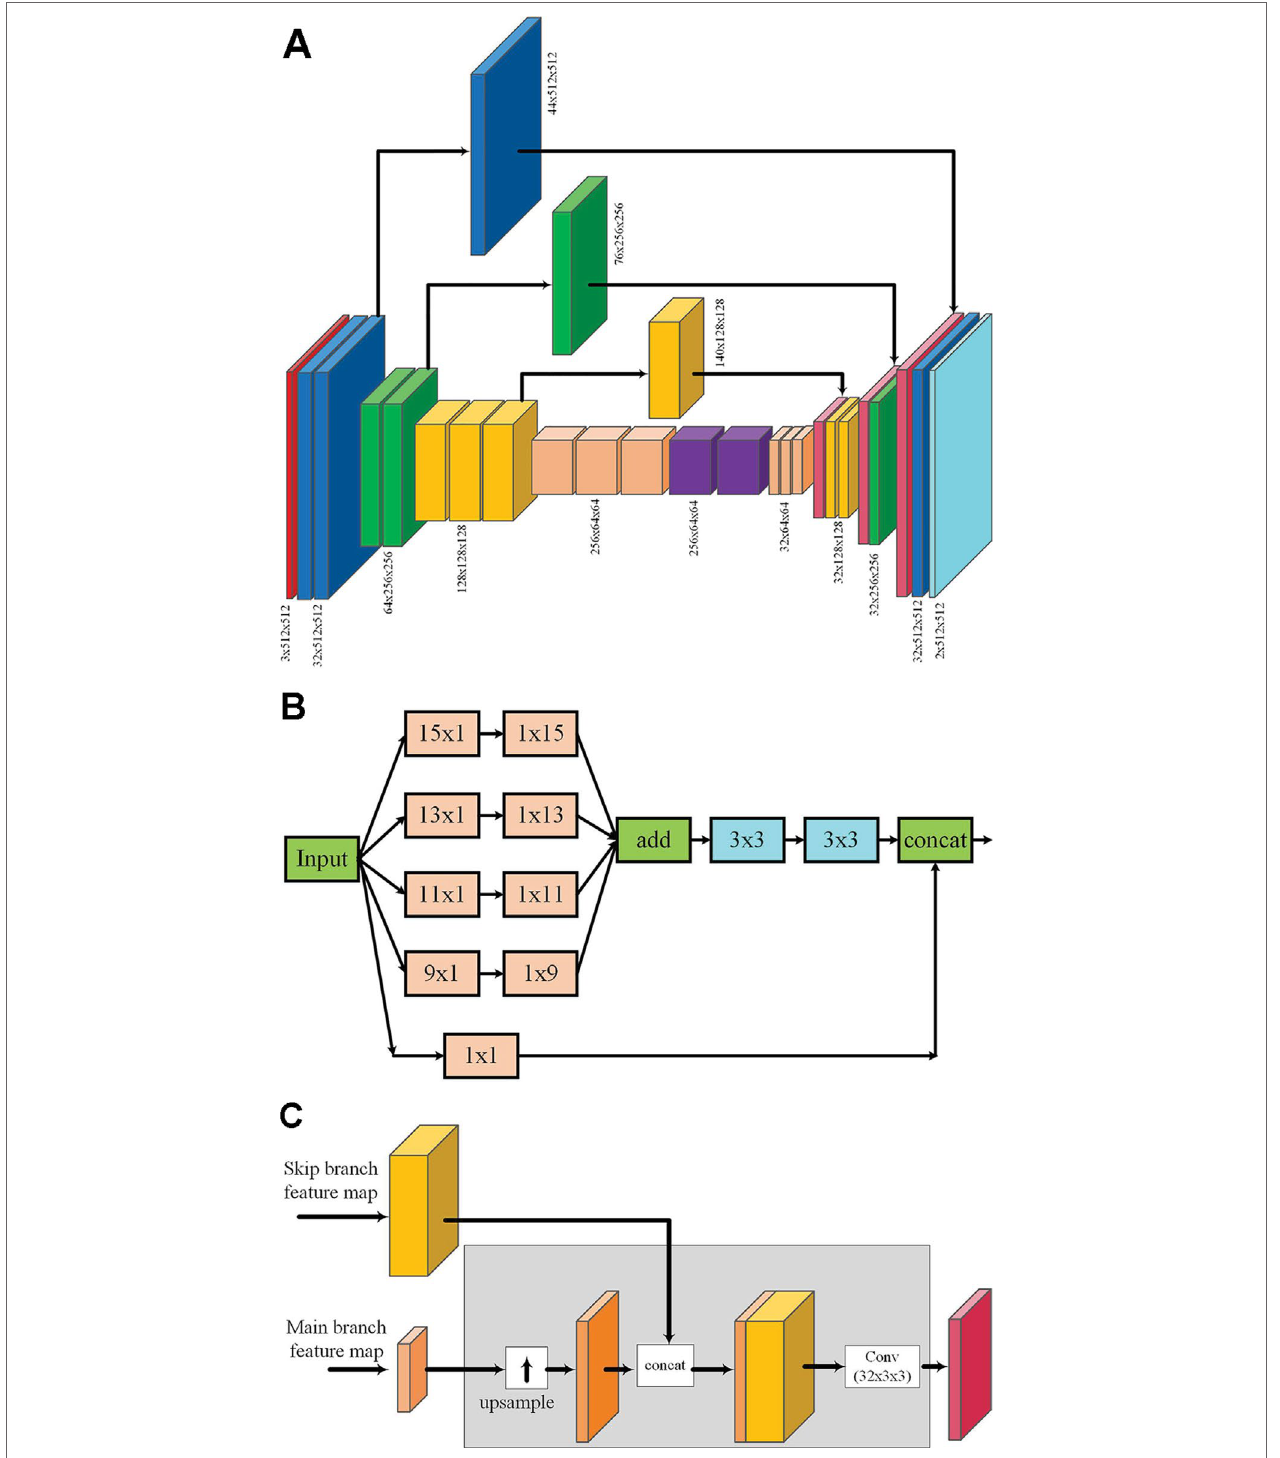
FIGURE 4 | ESNet : The proposed extended skip network for end-to-end learning of semantic graphics (A) . Diagram representing the output feature maps at each stage of the network (B) . Extended skip module: If Cin is the number of channels in the input, the output after 1 × 1 convolution has the same number of feature maps as the input, whereas to keep the computational complexity minimal, the number of feature maps at the output after other multi-scale filter banks is kept constant at 12. Hence, the total number of output feature maps of the skip module is ( Cin + 12). (C) The combined operations (up-sampling, concatenation, and convolution with fixed number of output feature maps) involved while merging feature maps from the extended skip module with the decoder. For simplicity, this detailed structure is not shown in (A) .